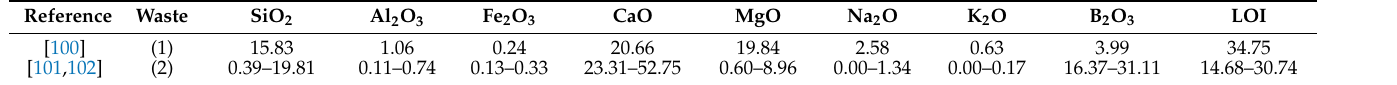
Table 7. Chemical composition (expressed wt.% oxide) of boron mining wastes.